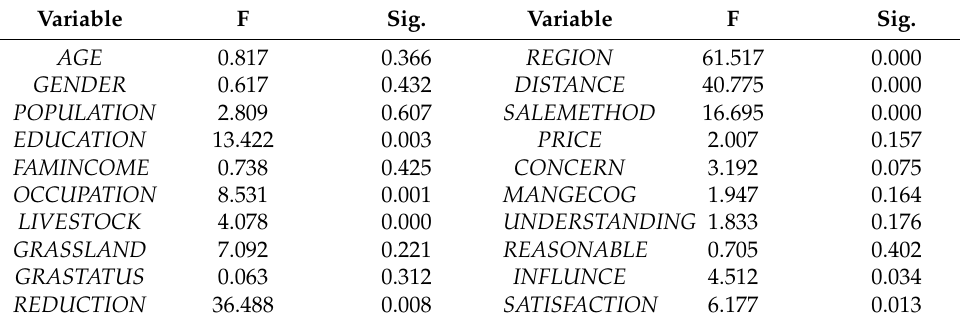
Table 6. The Levene test of error variance equivalence.